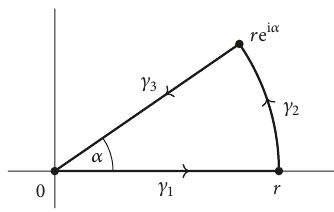
Figure 1: The model sector-curve 𝛾 = 𝛾 1 + 𝛾 2 + 𝛾 3 .